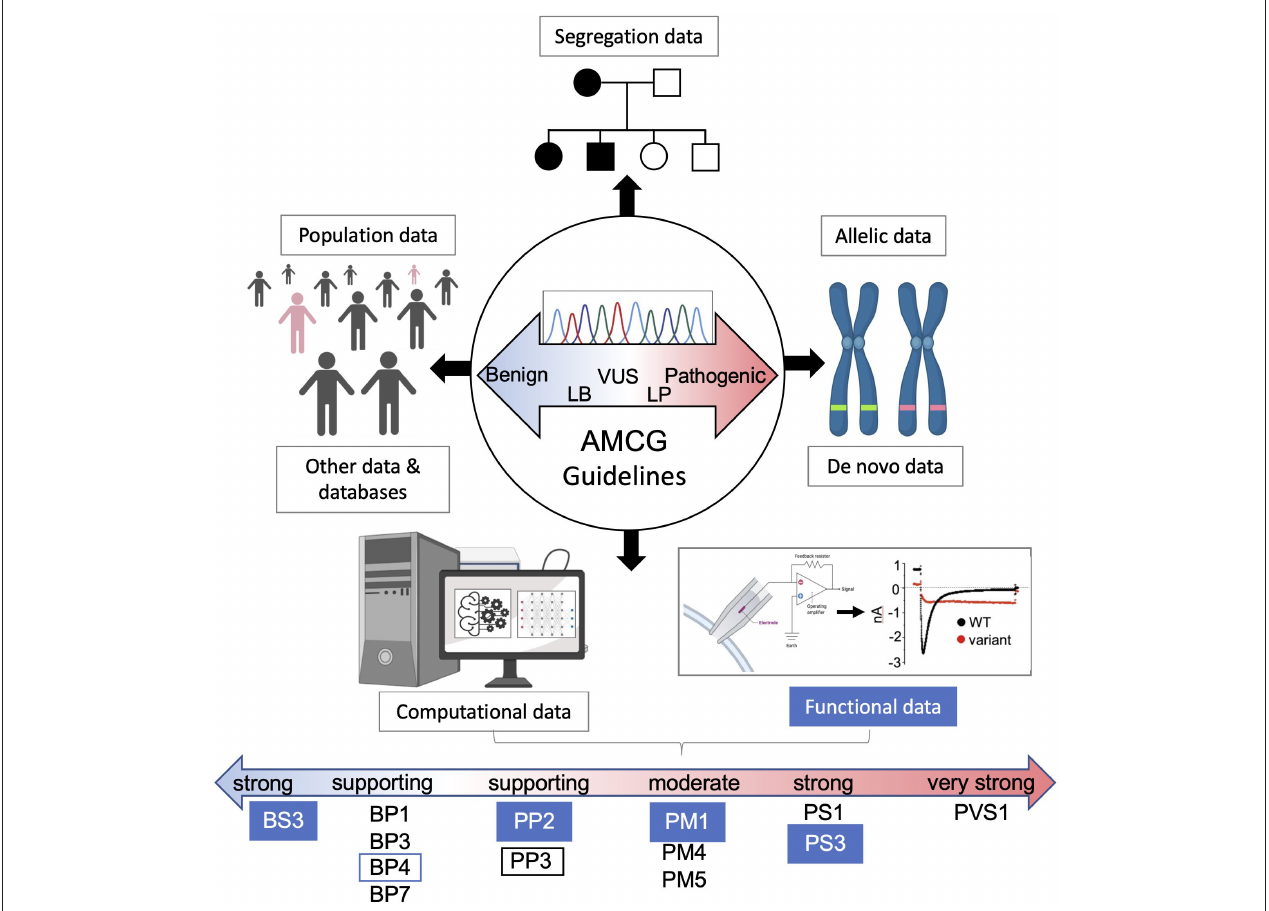
FIGURE 3 | AMCG Guidelines for variant interpretation. A brief overview of the eight lines of supporting evidence for evaluating variants of uncertain significance. Numerous benign and pathogenic supporting computational and functional levels are shown for each approach with functional evidence filled blue. The lines of evidence described by Richards et al. (27) in the guidelines are as follows: BS3/PS3, not damaging/damaging functional studies; BP1, missense variant in a gene with primarily truncating variants; BP3, indels in repeat region without known function; BP4/PP3, multiple lines of computational evidence showing no damaging effects/damaging affects; BP7, non-splicing, silent variant; PP2, variant in gene where pathogenic variants are common and benign variants are few; PM1, variant hotspot without benign variants; PM4, protein length changing variant; PM5, variant at residue with other pathogenic variants; PS1, amino acid change same as other pathogenic variant(s); PVS1, null variant in a pathogenic gene with known